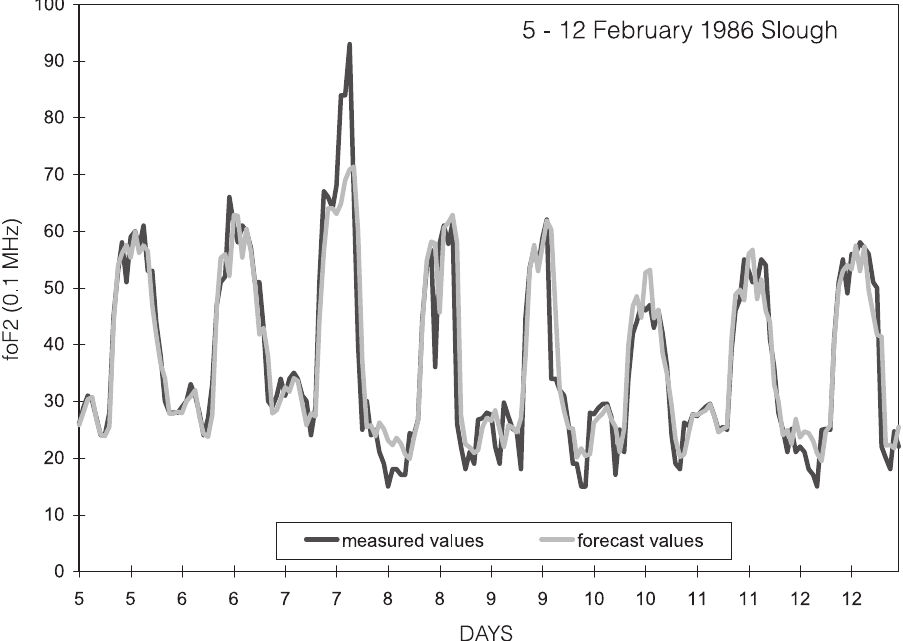
Fig. 1. Measured and NNARX model forecast foF 2 values for a 8 day period in February 1986 at Slough ionospheric